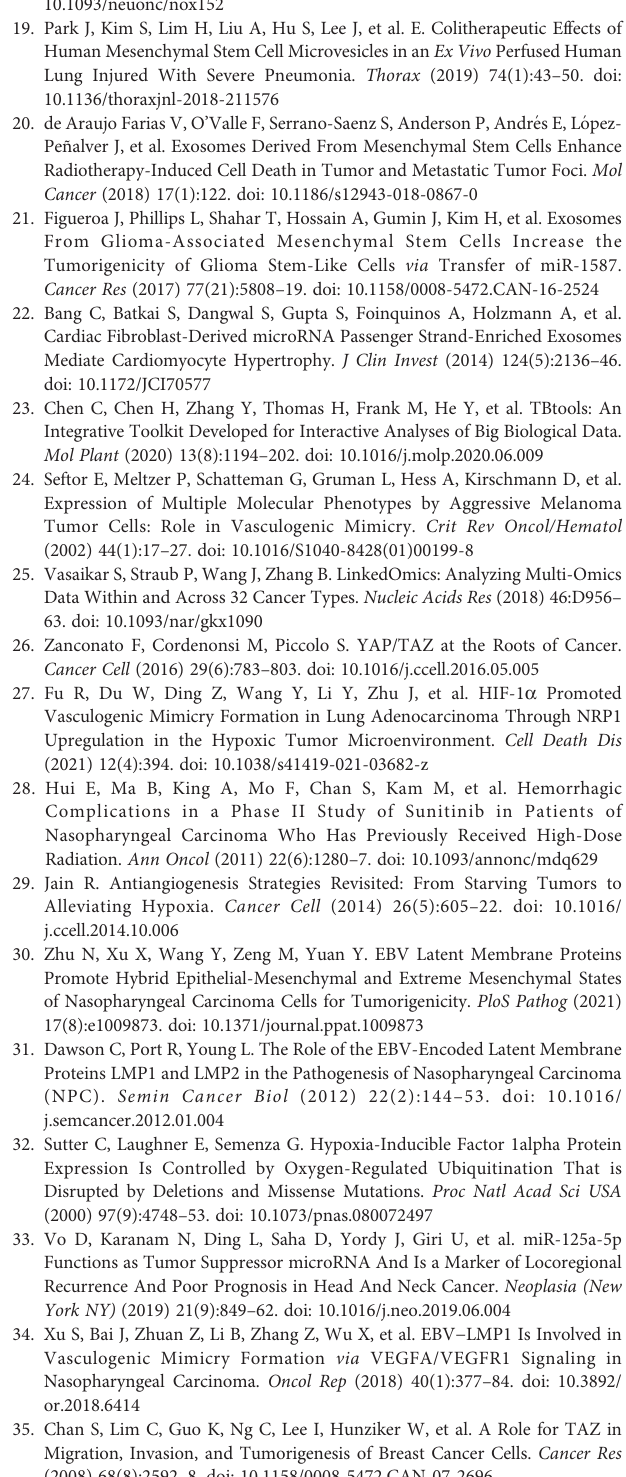
increased after knocking down miR-125a. (B) Rescue assay. The function on EMT- related markers of high-level of miR-125a was offset by over-expressing of